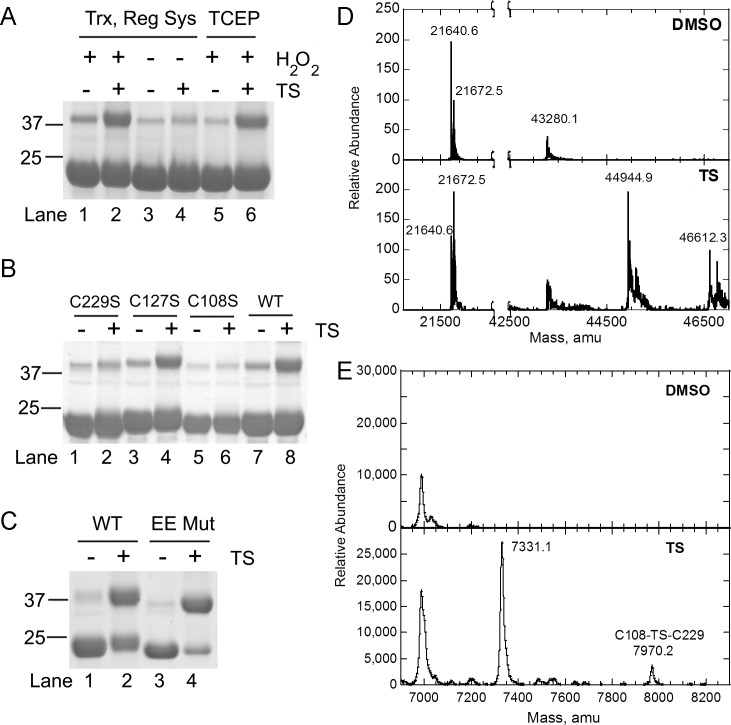
TS adducts specific cysteines of rPRX3 in vitro.(A) In vitro reaction between recombinant wild type (WT) PRX3 (100 μM) and 200 μM TS. Reactions contained either the Trx regeneration system or TCEP. The samples were treated with 6 successive additions of 100 μM H2O2 and 200 μM TS, as indicated. Samples were resolved by reducing SDS-PAGE and visualized by staining for total protein with GelCode Blue. (B) WT PRX3 or the indicated PRX3 mutants were incubated with or without TS as in panel A and formation of irreducible PRX3 dimers was visualized by staining for total protein after reducing SDS-PAGE. (C) WT PRX3 and the dimeric variant of PRX3 (EE Mut) were treated with 200 μM TS. (D) MS analysis of TS adducts. The EE Mut samples shown in lanes 3 and 4 of panel C were treated with 20 mM DTT to reduce disulfide bonds and to block further reactions of thiostrepton dehydroalanines with PRX3 thiols. The molecular weight of the resulting PRX3 adducts were determined by ESI-TOF MS. The signals at 21640.6 and 21672.5 atomic mass units (amu) correspond to the average molecular weight of the reduced monomer (-SH, 21640.6 amu) and sulfinic acid monomer (-SO2, 21672.6 amu), respectively. The peak at 43280.1 amu corresponds to a PRX3 dimer containing one disulfide (theoretical MW = 43,278.2) that presumably occurs as a result of trace amounts of oxidants present during buffer exchange prior to MS analysis. The signals at 44,944.9 and 46,612.3 amu correspond to 2 PRX3 monomers linked by 1 (44,945.0 amu) and 2 (46,609.8 amu) thiostrepton adducts, respectively. (E) Samples from (D) were digested with trypsin and peptides were analyzed by MALDI-TOF MS. The peptide at 7970.2 amu corresponds to a single thiostrepton linked to both the C108 and C229 peptides in PRX3 (7971.0 amu).